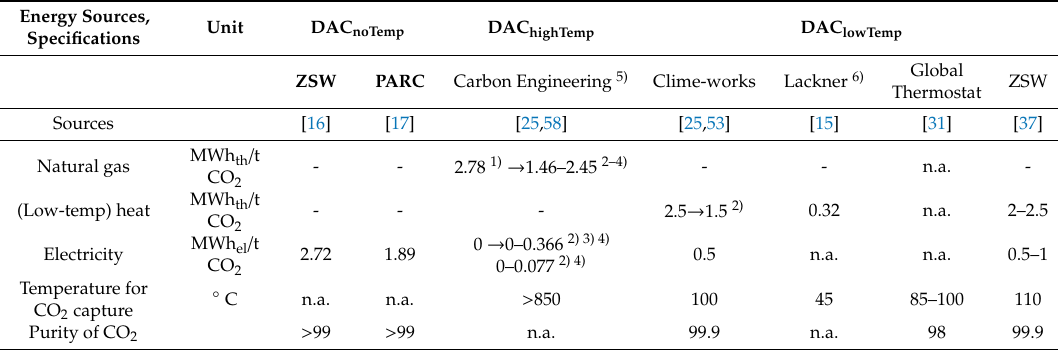
Table 4. Specific energy consumption of various types of Direct Air Capture (DAC)